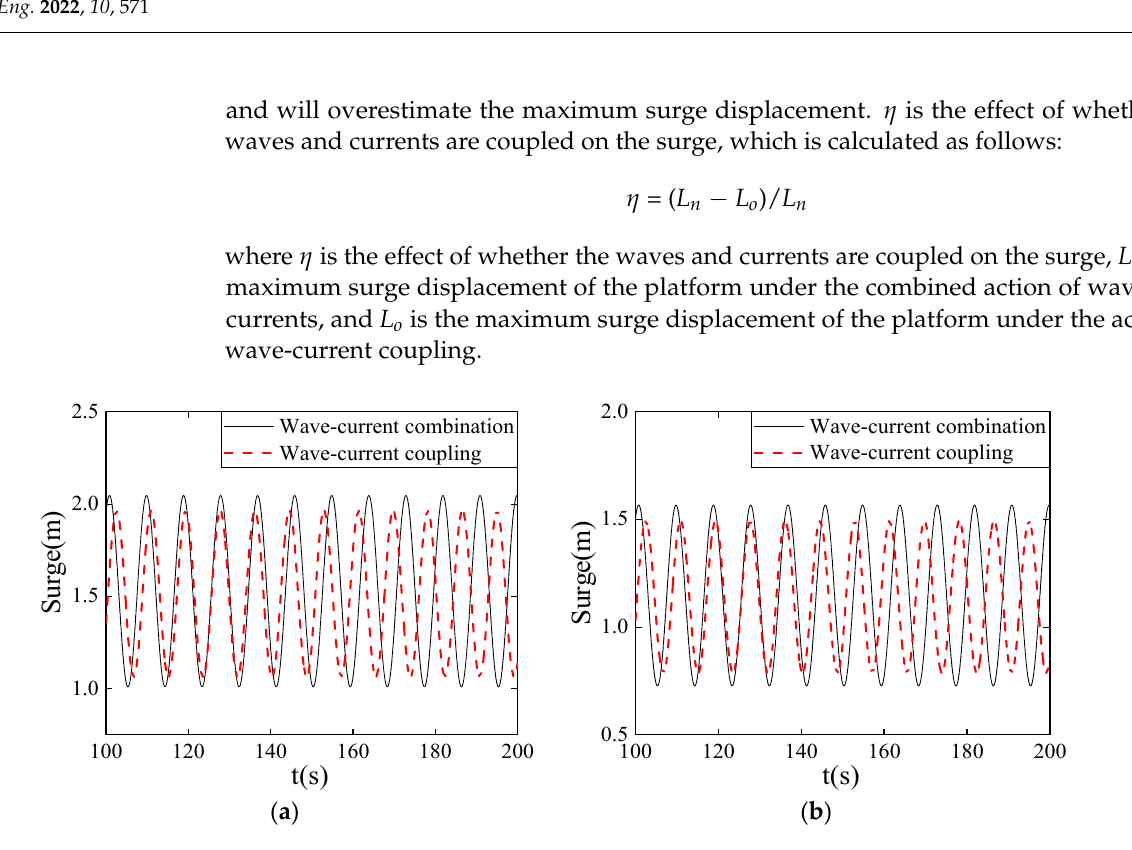
Figure 12. Surge response of the TLPs under the action of waves and currents: ( a ) the conventional TLP; ( b ) the Serbuoys-TLP.